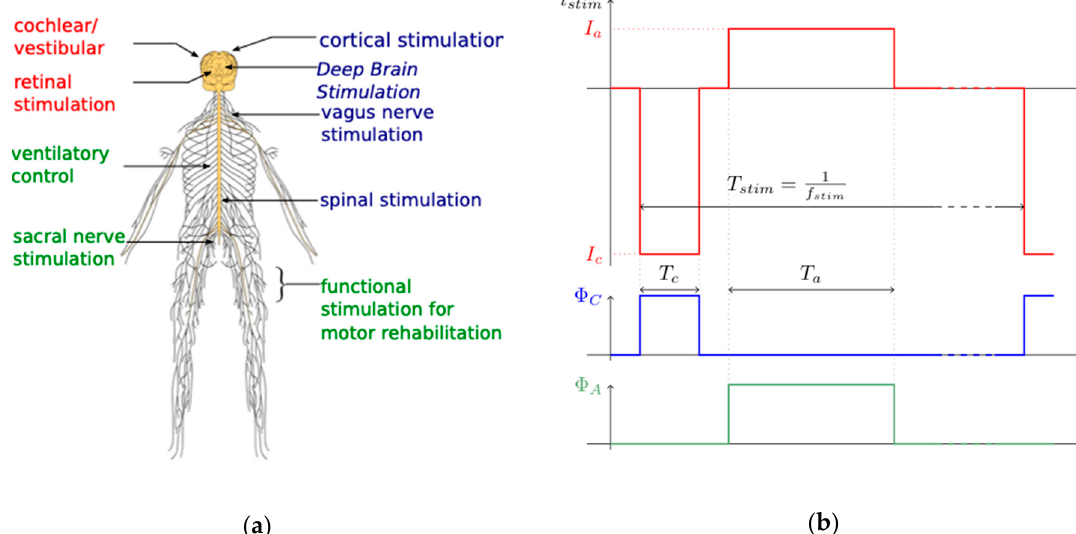
Figure 1. ( a ) Illustration of some therapeutic applications for electrical stimulation along the nervous system: in red, sensory feedback applications; in green, motor control applications; and in blue, those for the central nervous system. ( b ) Typical biphasic current stimulation waveform with active balancing. The cathodic current Ic is negative and applied during a time Tc required to trigger excitable cells, and the injected charge is then balanced using a positive anodic pulse of duration Ta . Both pulses are generated with current sources activated by Φ C and Φ A switching commands.